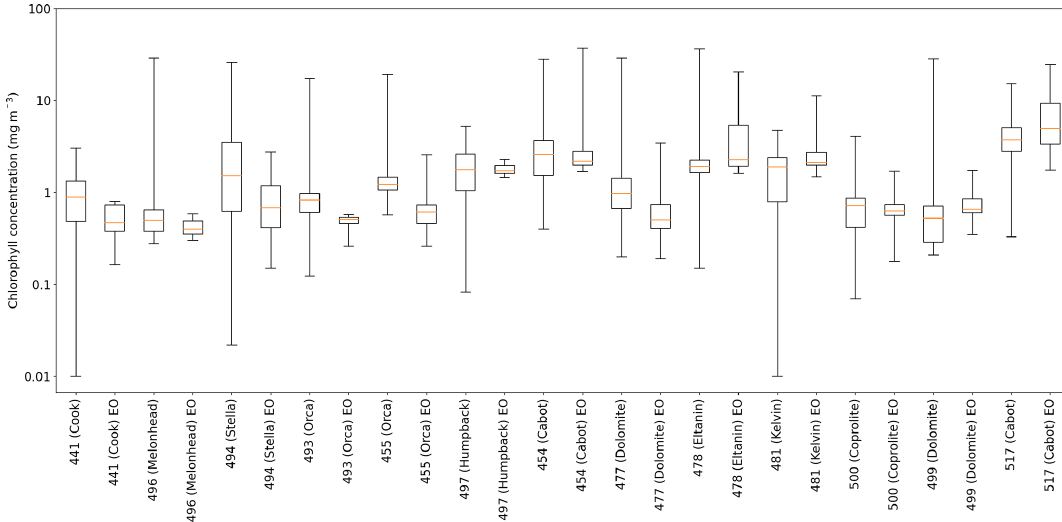
Figure 3. Statistical comparison of the surface chlorophyll values measured by each glider with its SEO trajectory counterpart. From bottom to top, the values shown on the box-and-whisker plot are the minimum, lower quartile range (25%), median, upper quartile range (75%), and maximum. Only the glider measurements with an SEO counterpart are